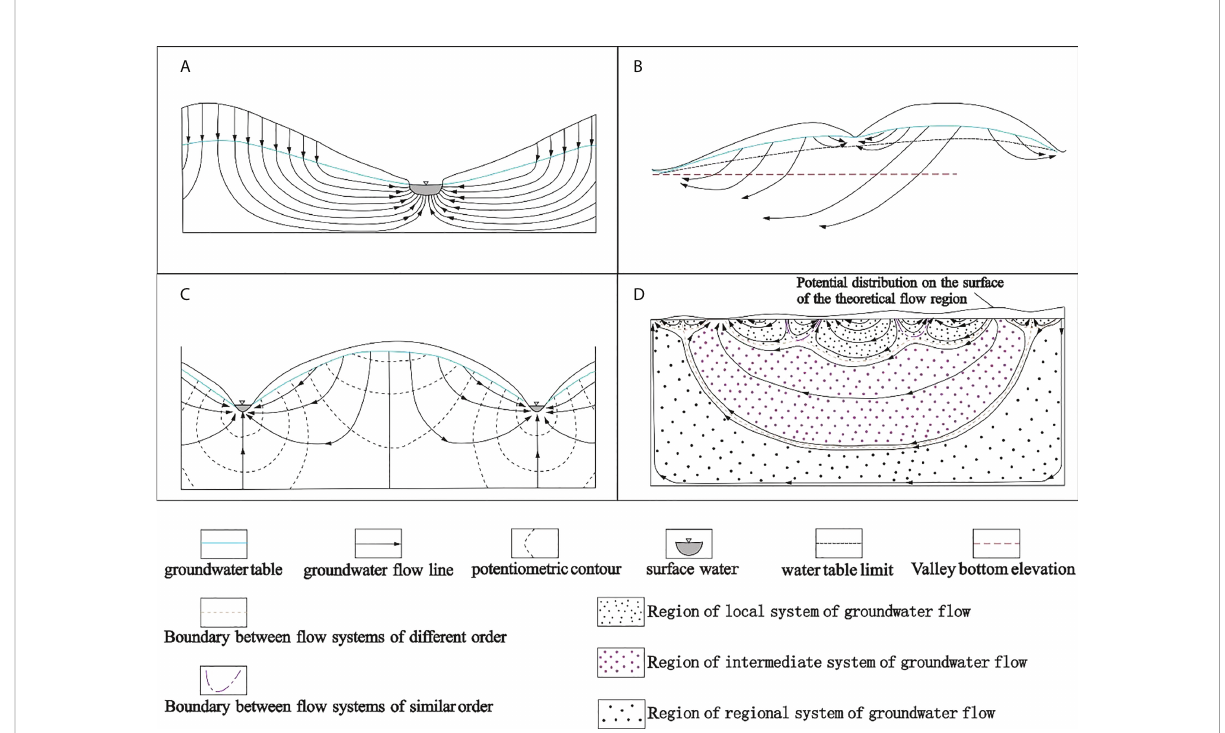
FIGURE 1 The evolution diagram of To ́ thian Theory (A) The cross-section drawn of the gravity-driven groundwater fl ow by King in 1899; (B) A pattern of complex fl ow in uncon fi ned aquifer by Fourmarier in 1939; (C) The groundwater fl ow net diagram of rivers block by Hubbert in 1940; (D) The use of upper head boundary for linear function and sine function superimposed conditions to conduct simulated groundwater fl ow fi eld by Toth in